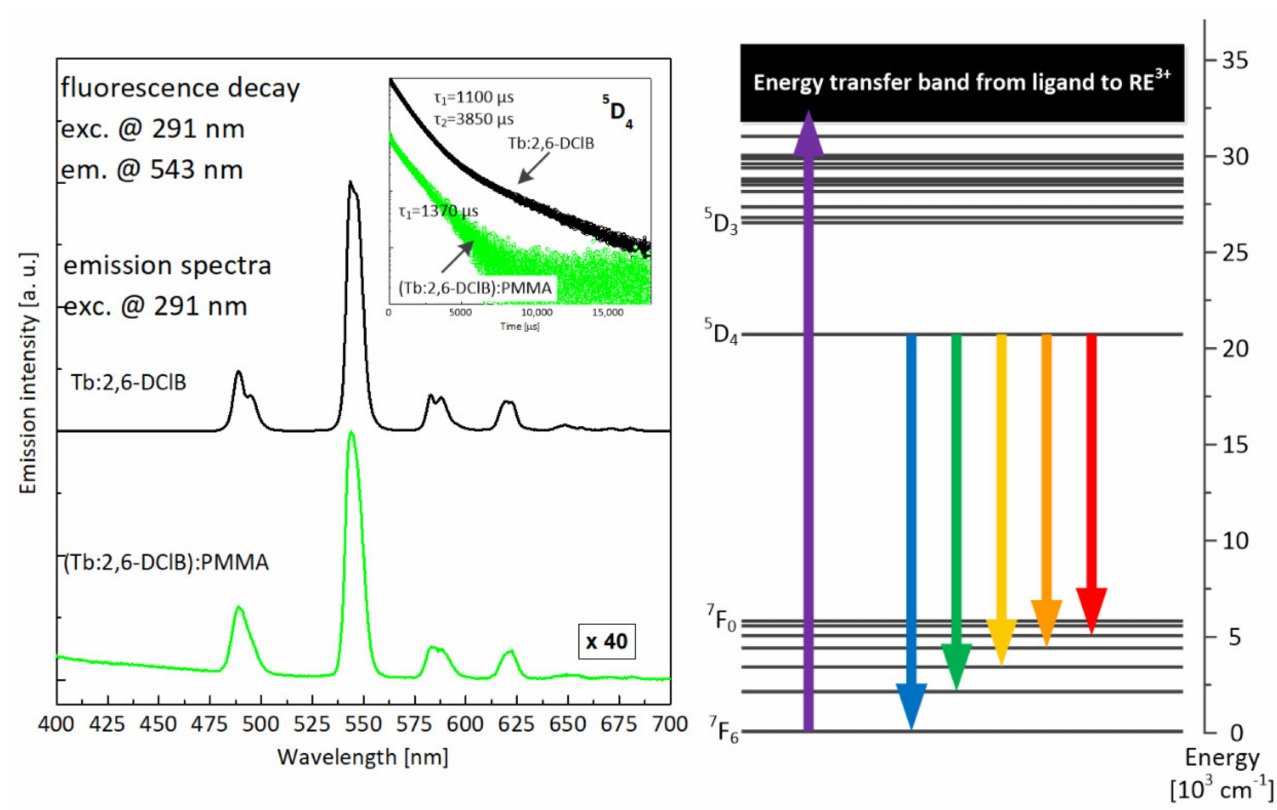
Figure 13. Comparison of luminescence spectra recorded for the Tb:2,6-DClB complex and the Tb:2,6-DClB/PMMA polymer composite (fluorescence decays for both materials shown in the inset) together with the attribution of the luminescent transition within the energy-level structure of terbium ion (on the right).